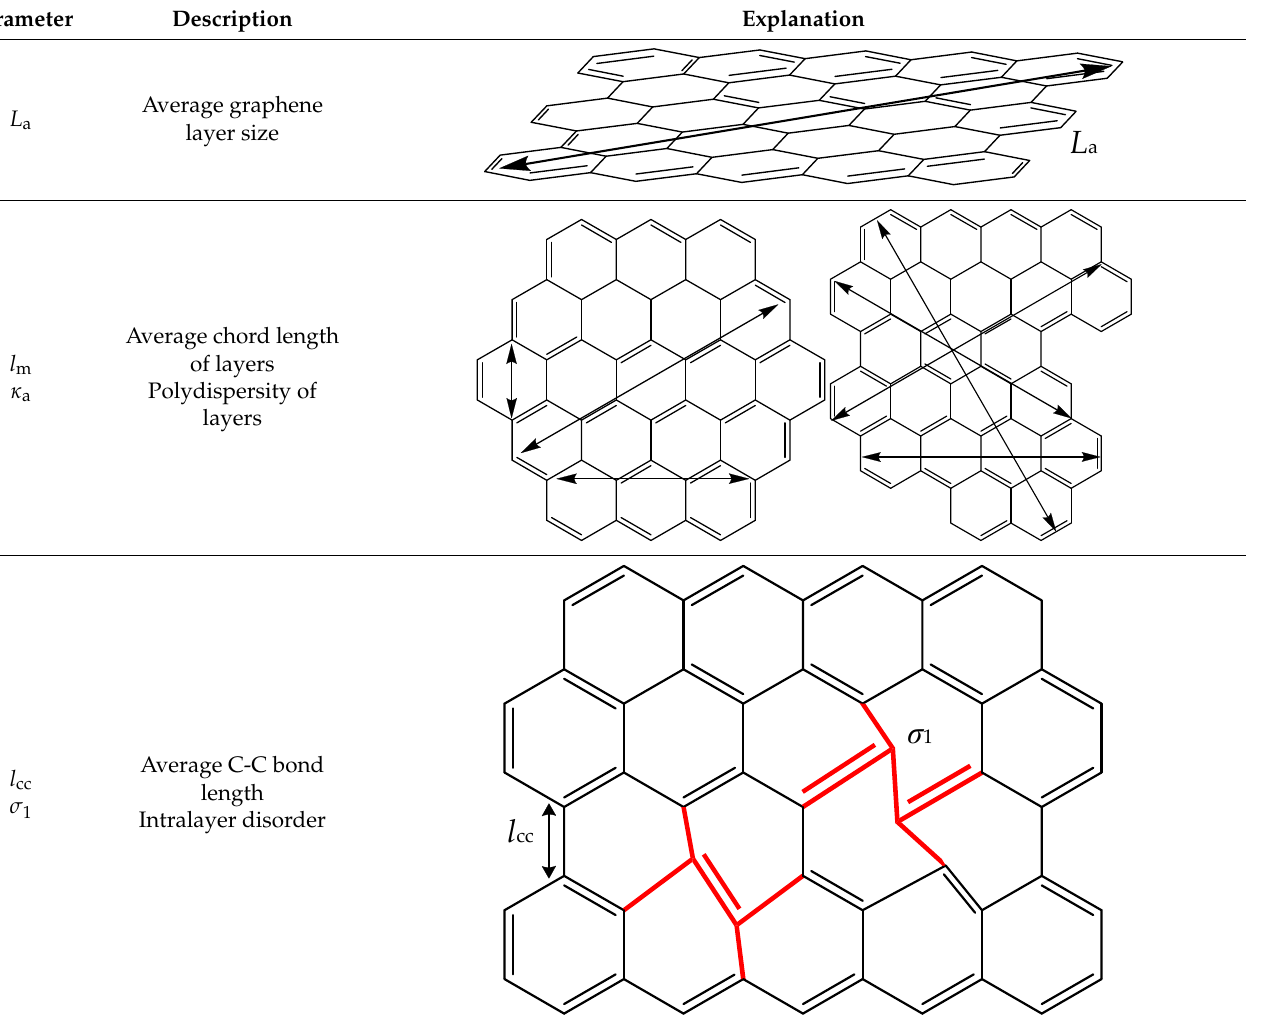
Table 1. Microstructure parameters describing the layer structure. Note that L a , l m and κ a are mathematically dependent on each other and calculated from a gamma distribution with the shape factors ν and α .